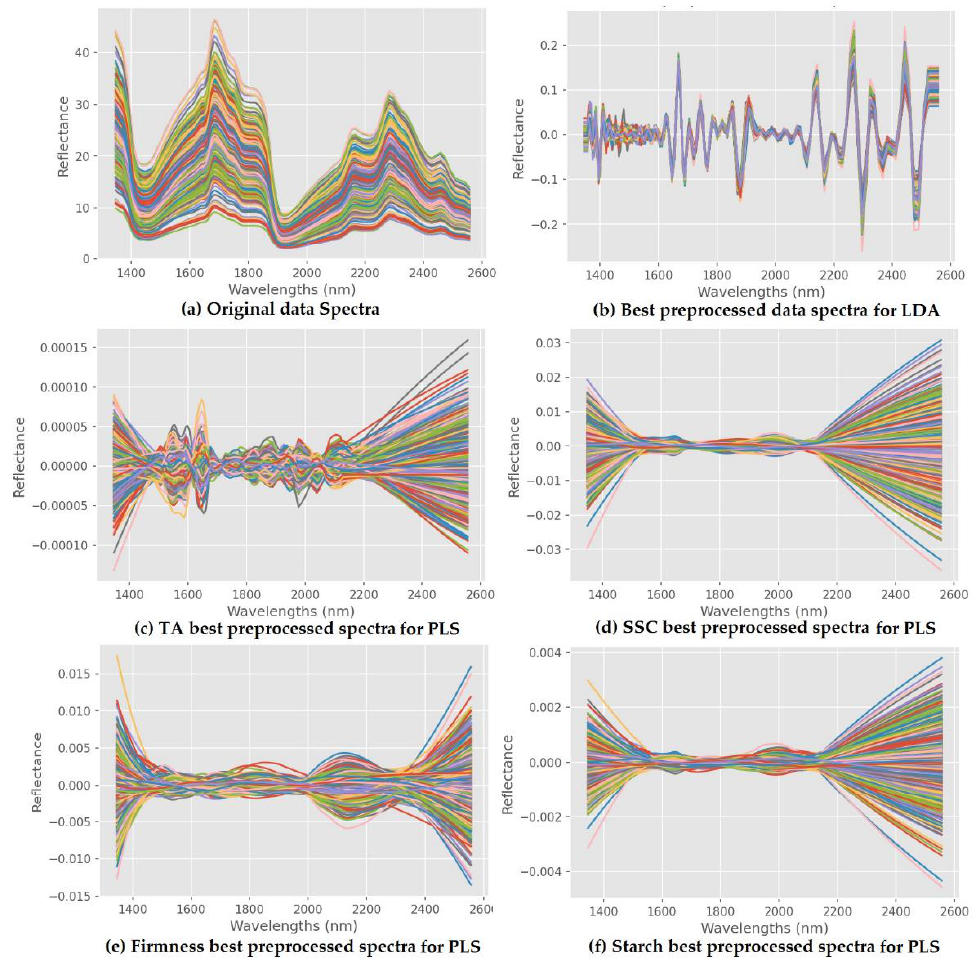
Figure 6. Original and spectral transformation of mango data spectra. Table 5. Comparison results of direct approach classification.